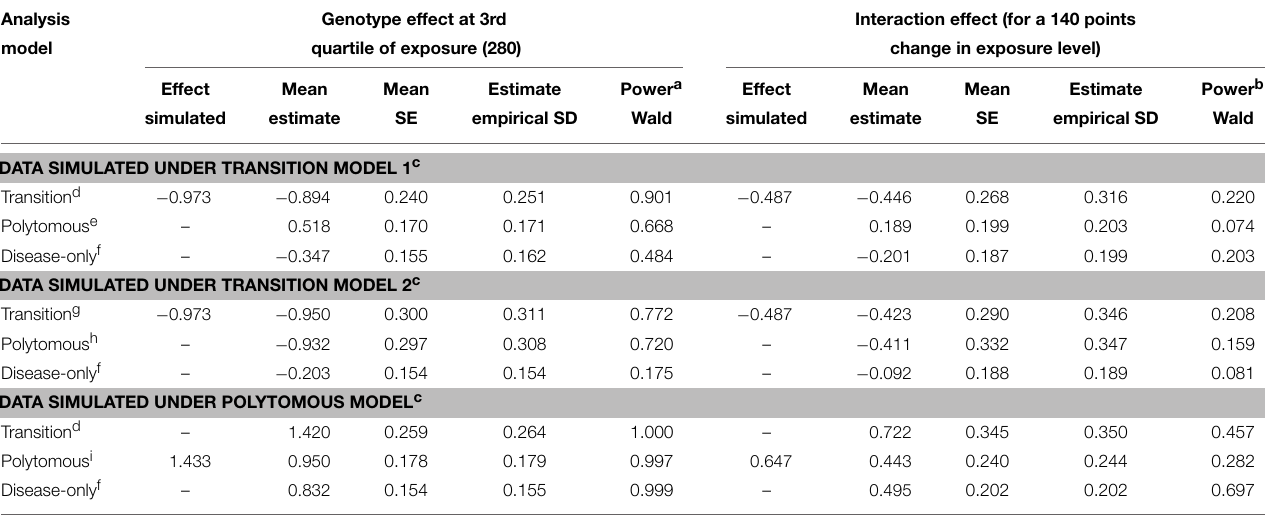
TABLE 3 | Simulation results with a continuous exposure.